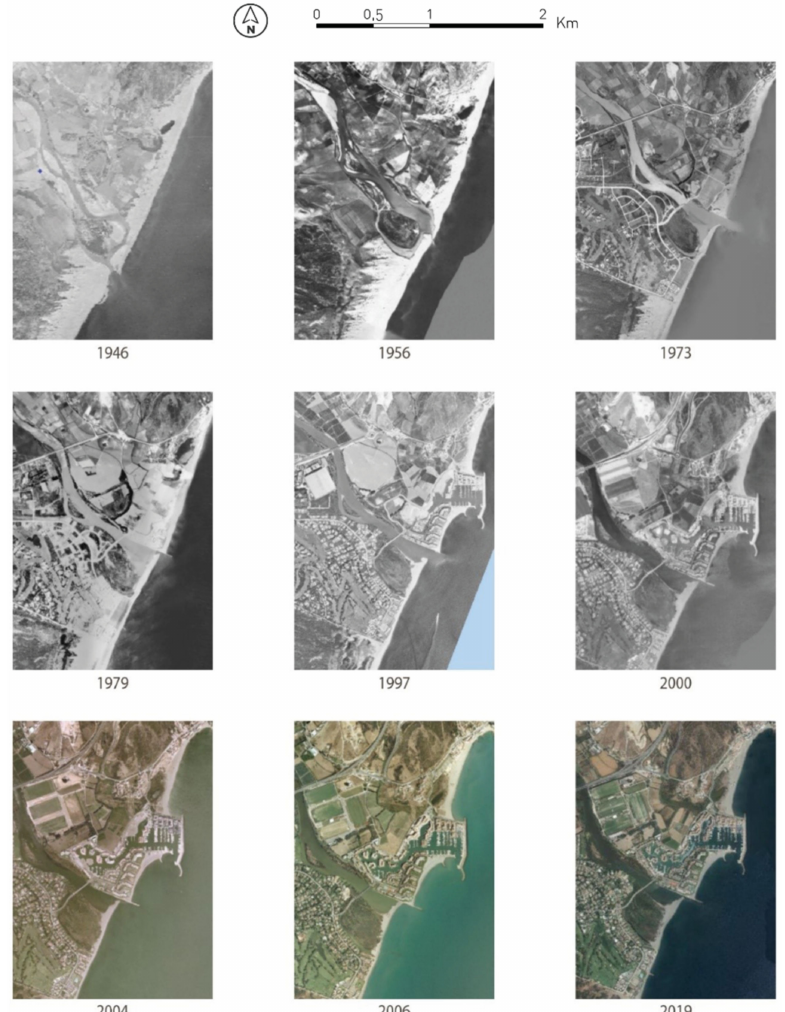
Figure 1. Satellite and aerial images from 1946 to 2019 showing the evolution of the Guadiaro estuary (source: